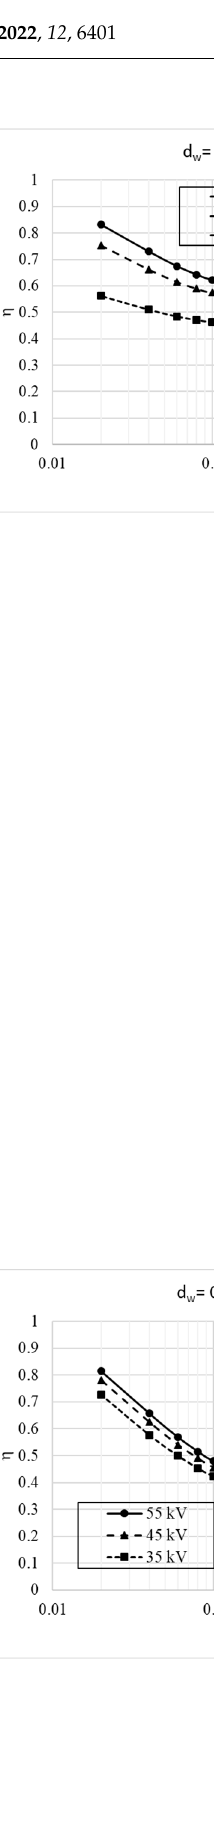
Figure 13. Variation of the ESP collection efficiency with particle diameter for S y = 115 mm, d w = 1